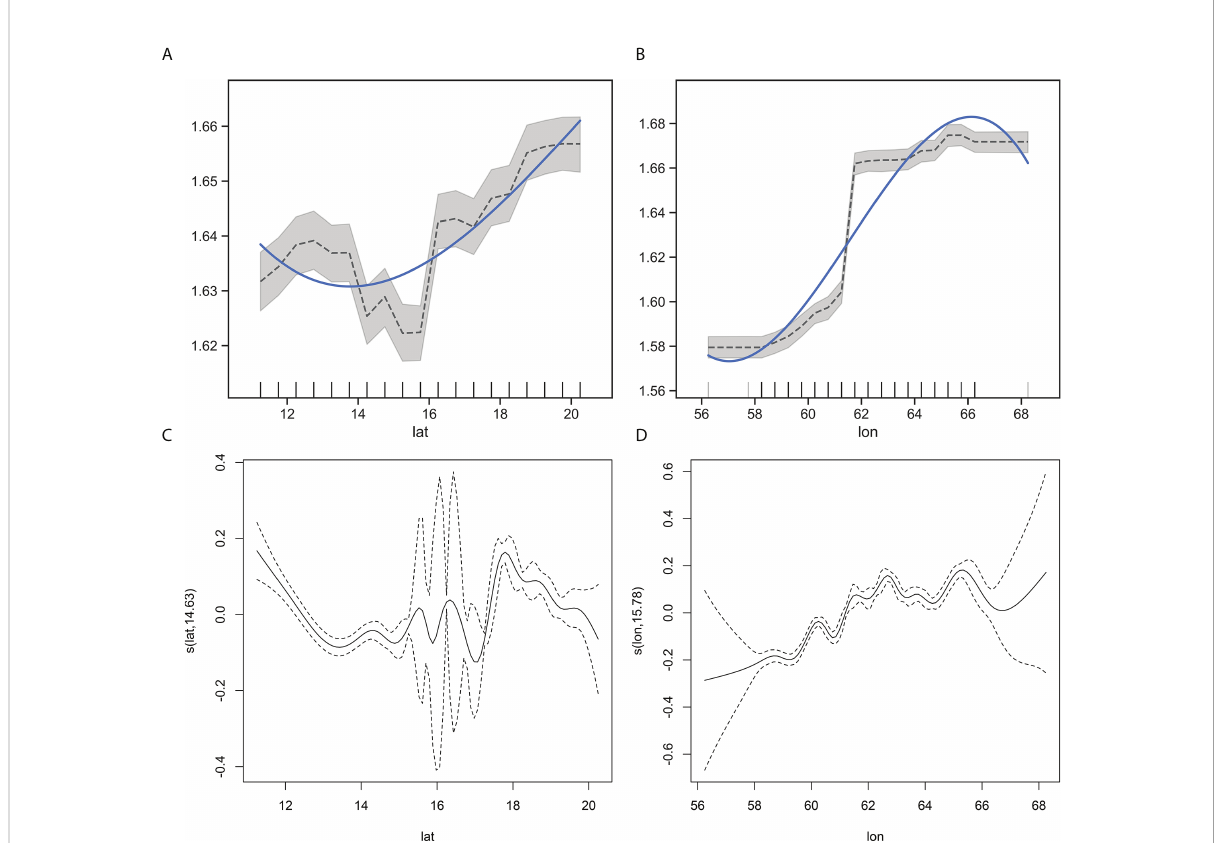
FIGURE 12 Partial correlation diagram of RF and GAM model of the in fl uence of spatial variables on CPUE. (A) lat, (B) lon, the black curve is the in fl uence curve of variable on CPUE, the blue curve is the fi tting of the trend of the in fl uence curve, and the gray area is the 95% con fi dence interval; (C) lat, (D) lon, the solid line is the in fl uence curve and the 95% con fi dence interval between the two dashed